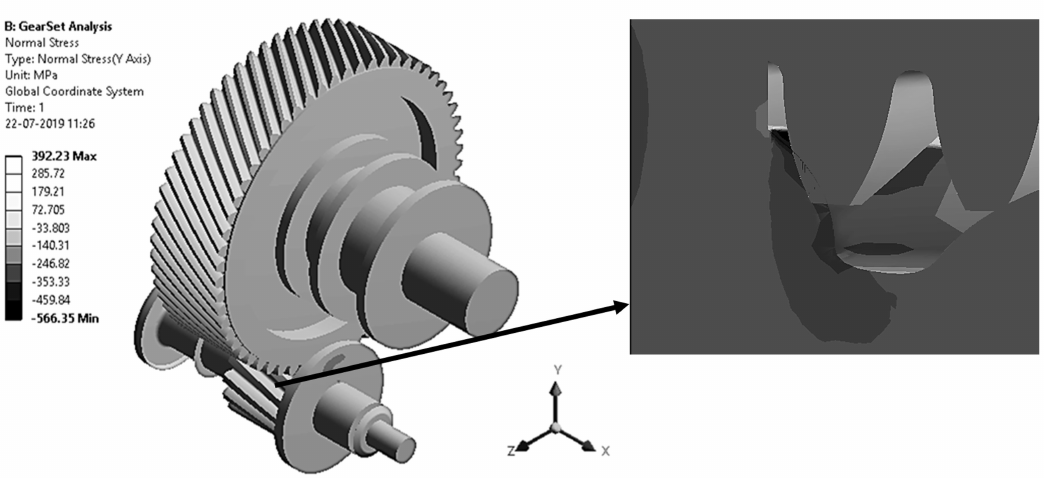
Figure 8. von-Mises contact stress at the interface of pinion and gear teeth.